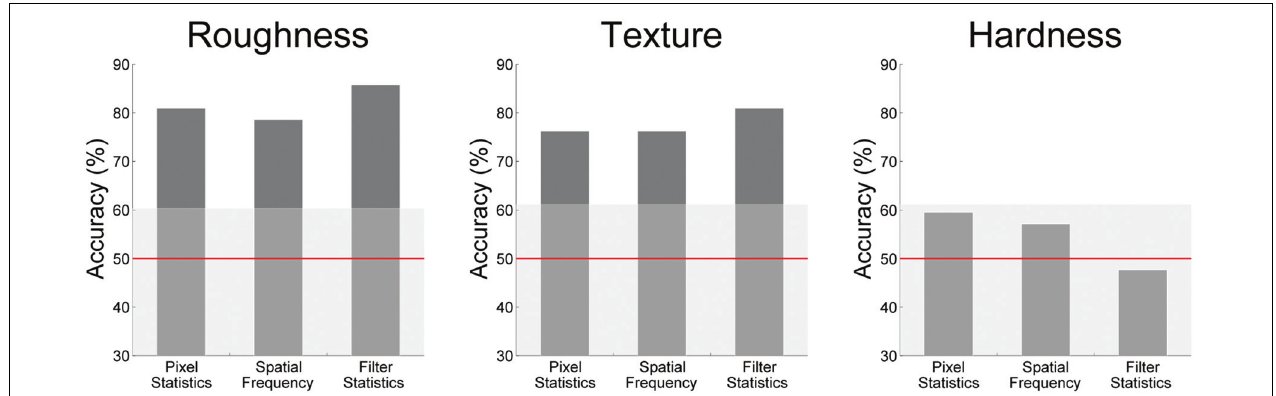
FIGURE 4 | Accuracies of the image statistic classifier. The shaded area indicates the p -threshold resulting from the permutation test ( p < 0.05, one-tailed test, 500 permutations).